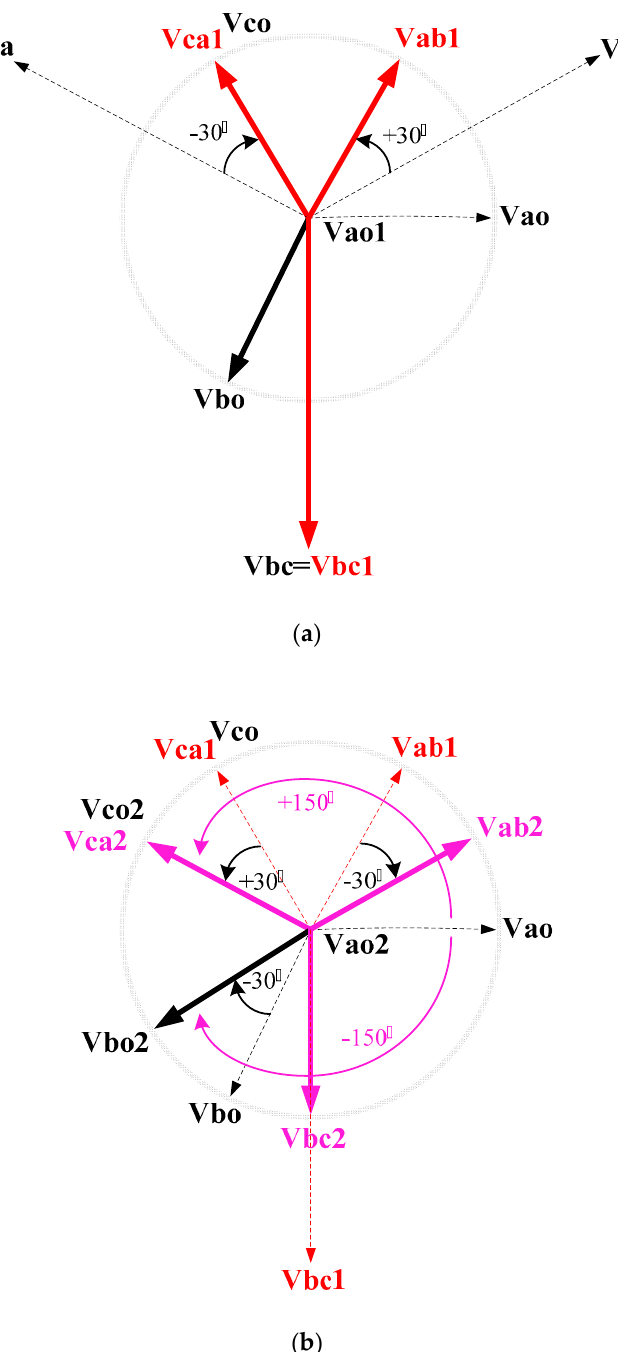
Figure 12. Voltage phasor diagram of fault-tolerant control when a fault occurs in the switch S a 1 + : ( a ) unadjusted voltage phase angle; ( b ) adjusted phase angle of the b-phase voltage such that it is 150° behind that of the a -phase voltage; adjusted phase angle of the c-phase voltage such that it is 150° ahead of that of the a -phase voltage.